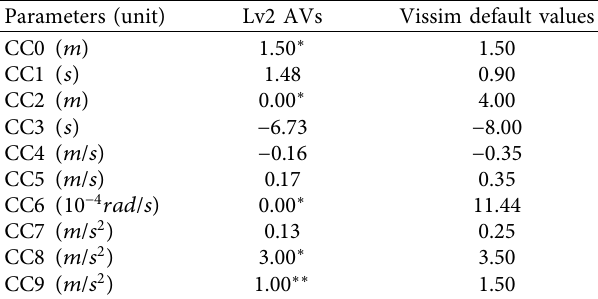
Table 12: Summary of our estimates for Lv2 AVs and Vissim default